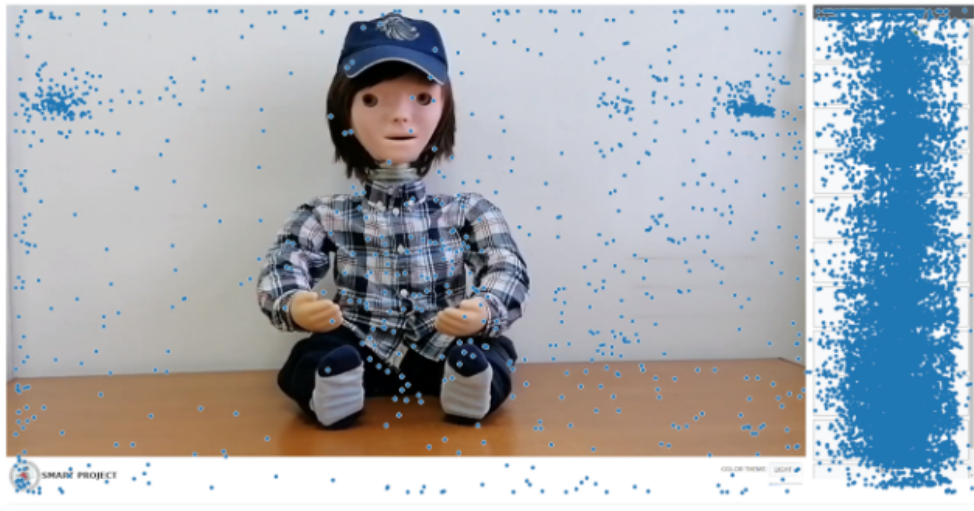
Figure 10. Positions of the all clicks/taps on the application.